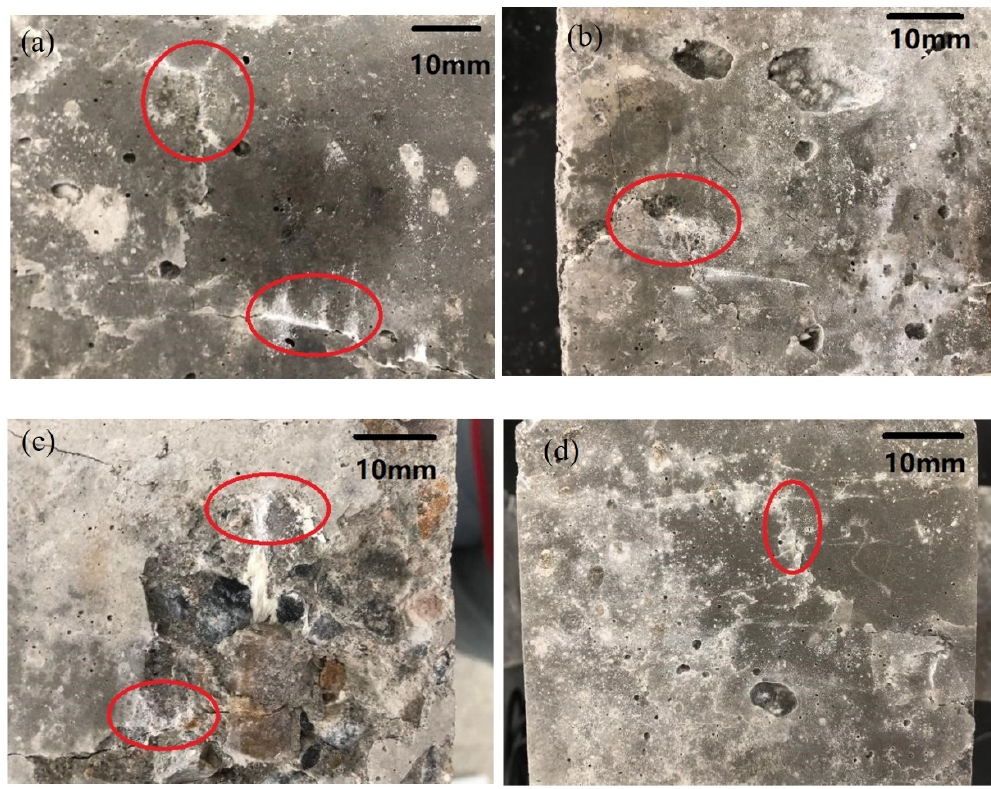
Figure 6. Healed specimen. ( a )After healing in A2B2C3 group. ( b ) After healing in A1B2C2 group. ( c ) After healing in A3B3C2 group. ( d ) After healing in A2B2C2 group.